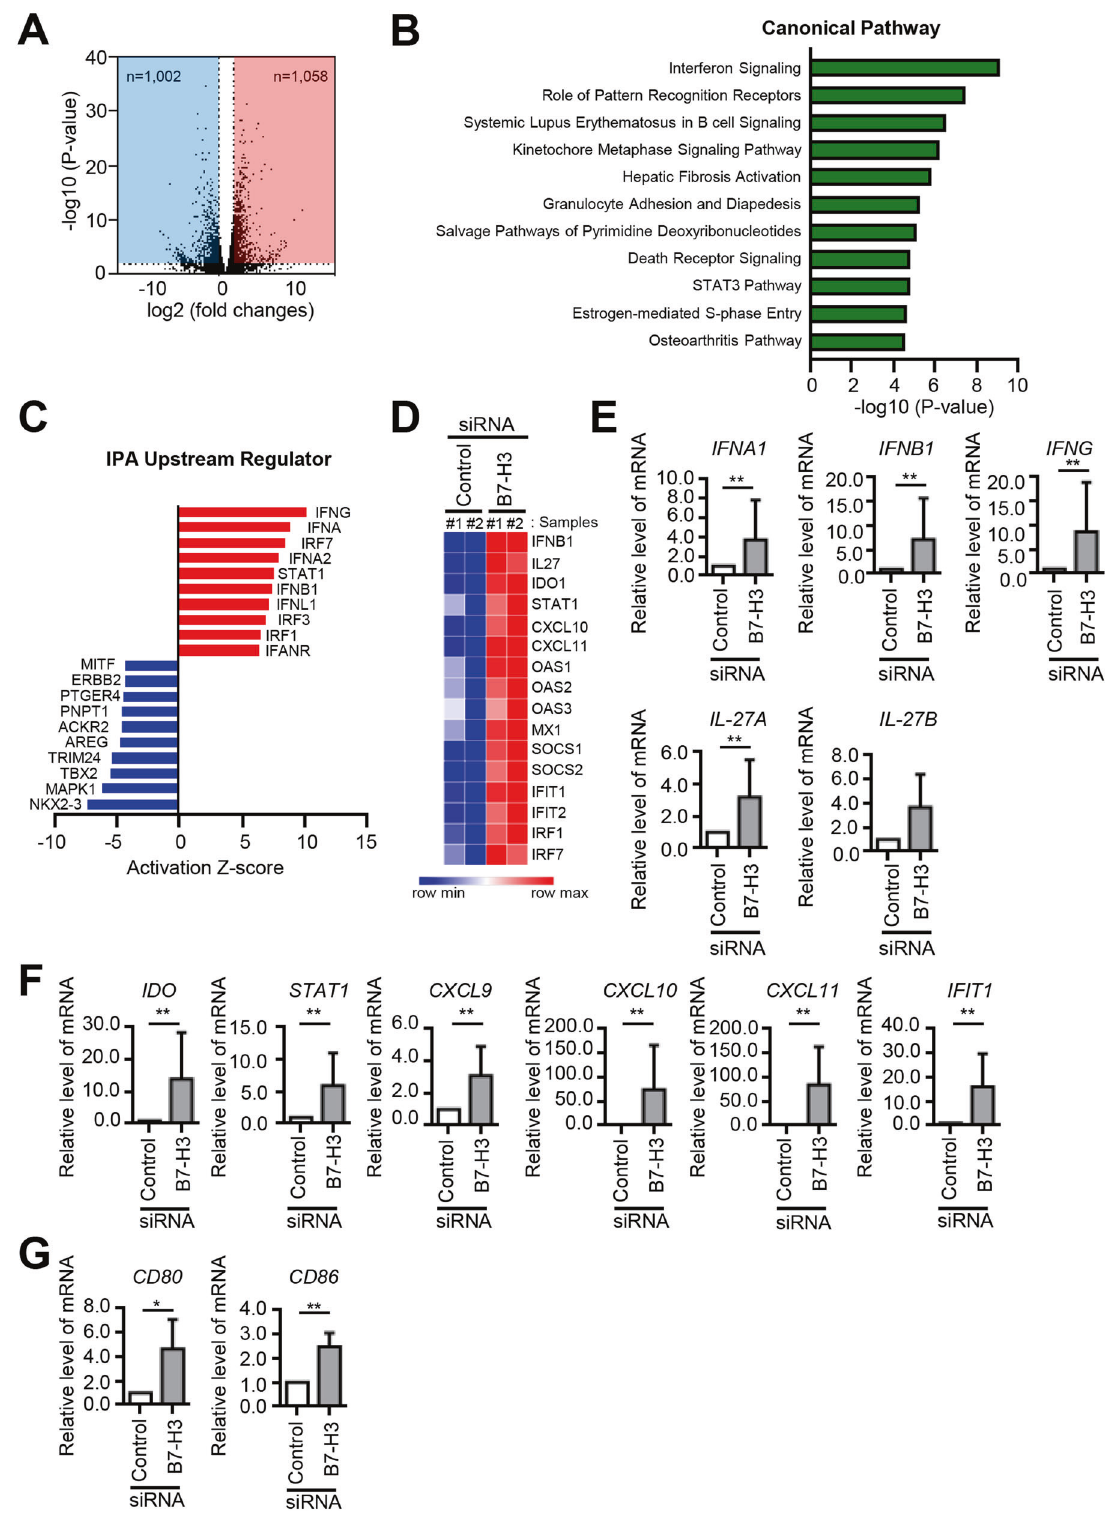
Fig. 3 B7 – H3 de fi ciency activates IFN signaling. A M-CSF (40 ng/ml) was added to monocyte culture for three days and then the cells were transiently transfected with B7 – H3-speci fi c siRNA or control siRNA (40 nM) for one day. Gene expression was analyzed using RNA sequencing (RNA-seq) and depicted using a volcano plot. The x axis indicates the log 2-fold changes in gene expression, such that data points plotted to the right indicate increased and left indicates decreased expression, respectively. B A simple bar graph depicting the 11 topmost enriched pathways. Higher values on the x axis indicate greater statistical signi fi cance. C A bar graph depicting the top 10 most upregulated (red) and downregulated (blue) potential upstream genes derived from Ingenuity Pathway Analysis (IPA). D Heatmap of RNA-seq CPM values for STAT1- activating and -dependent genes in B7 – H3-de fi cient OCPs. RNA-seq data from 2 biological replicates were used. E , F , G Differentially expressed genes were analyzed using RT-qPCR. The mRNA levels were normalized relative to GAPDH expression. Cell Death and Disease (2021)